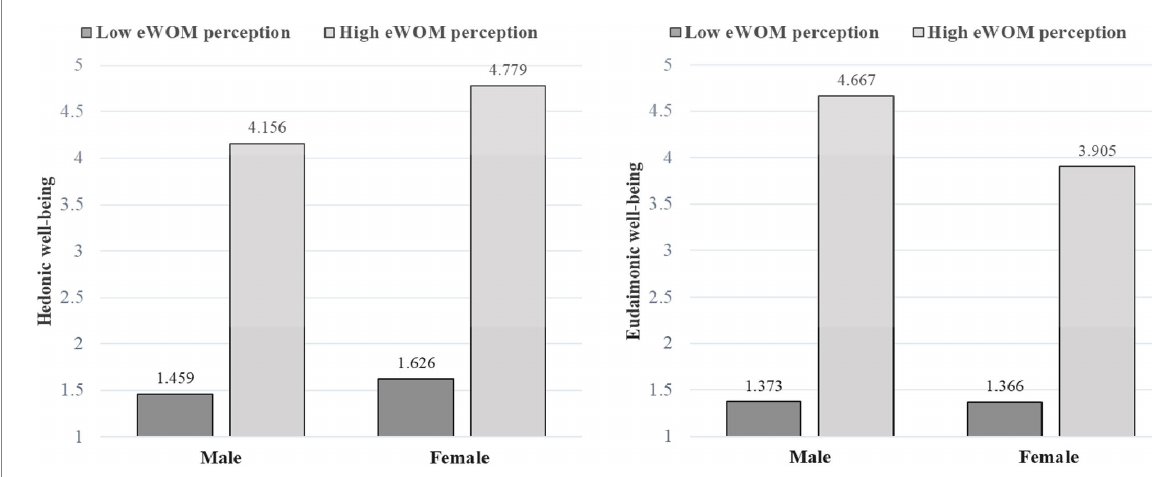
FIGURE 2 Interaction between eWOM perception and gender identity.